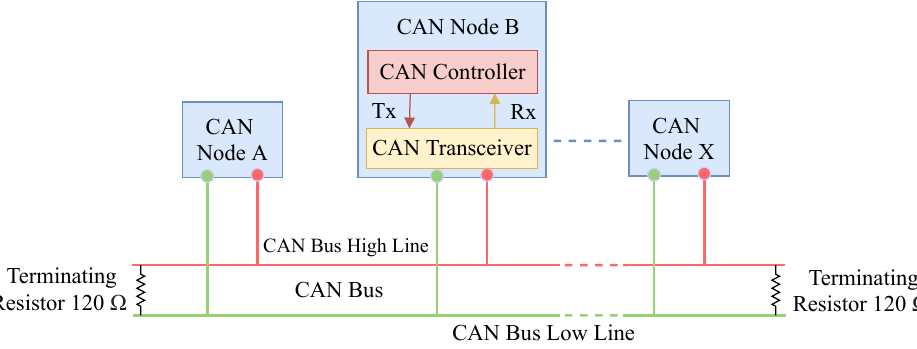
Figure 1. The standard CAN bus node